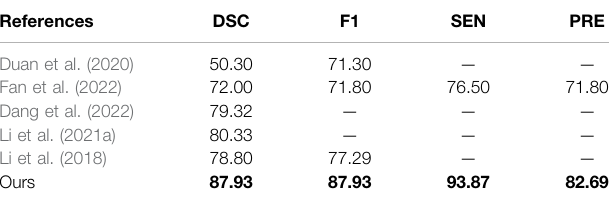
TABLE 6 | Comparison of previous brain objects segmentation studies and ours.